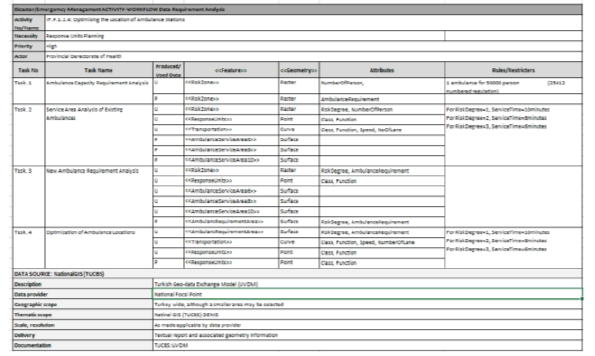
Table 1. Data requirement analyse for ‘Optimising the Location of Ambulance Stations’ activity